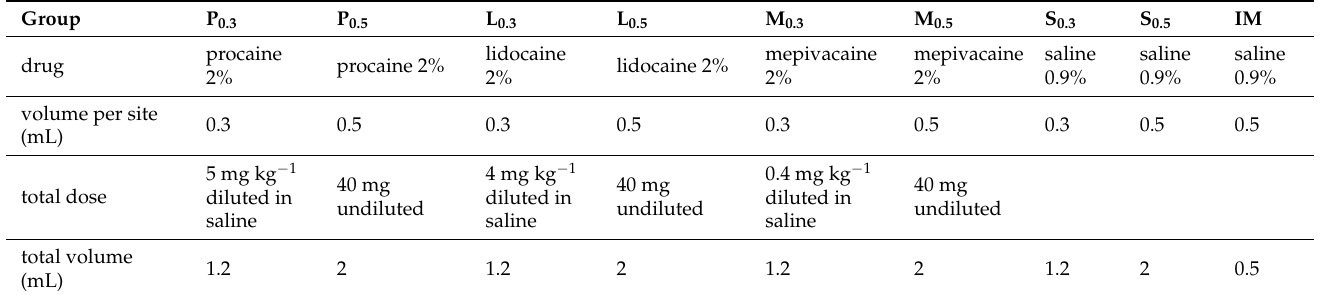
Table 1. Treatment groups, injected volume, total dose and concentration of the local